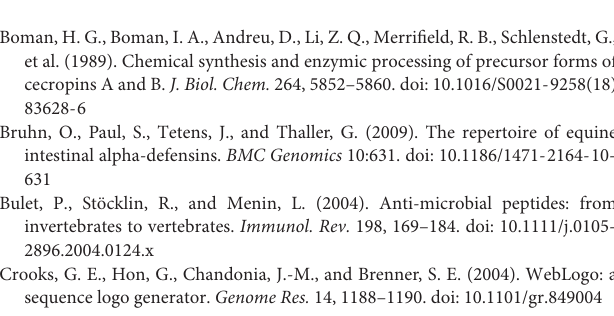
Supplementary Figure 1 | Schematic illustration of the experimental design. Supplementary Figure 2 | HPLC profiles and spectrometric data of the synthetic AMPs. Supplementary Figure 3 | Evaluation of hemolytic and cytotoxic activities of synthetic AMPs. The hemolysis effects (left) and cytotoxicity on normal cells (right) of the synthetic peptides at different concentration were tested on mice erythrocytes and HEK293 cells, respectively. PBS and Triton-X100 were used as the negative and positive control. No apparent hemolysis or cytotoxicity was detected among groups. Supplementary Figure 4 | CD spectrum of the designed AMPs interacted with fungal genomic DNA. The top curve corresponded to free DNA, while the lower curves were that mixed with respective AMPs. The decreased intensities of genomic DNA molar ellipticity exhibited occurrence conformational alteration of DNA that induced by AMPs, which suggested a DNA-binding mechanism of the designed sequences. Supplementary Figure 5 | Helical wheel projection analysis of the designed peptide. (A) N-terminal amphiphilic helix of cecropin A; (B) C-terminal hydrophobic helix of cecropin A; (C) N-terminal amphiphilic helix of cecropin B; (D) C-terminal hydrophobic helix of cecropin B; (E) helical segment of defensin A; (F) helical segment of defensin B; (G) helical segment of moricin A. Supplementary Table 1 | Papilionoidea species and their high-throughput sequencing data used in this study. Supplementary Table 2 | The AMP sequences for phylogenetic analysis in this study. Supplementary Table 3 | Sequence alignment of the synthetic and naturally occurring